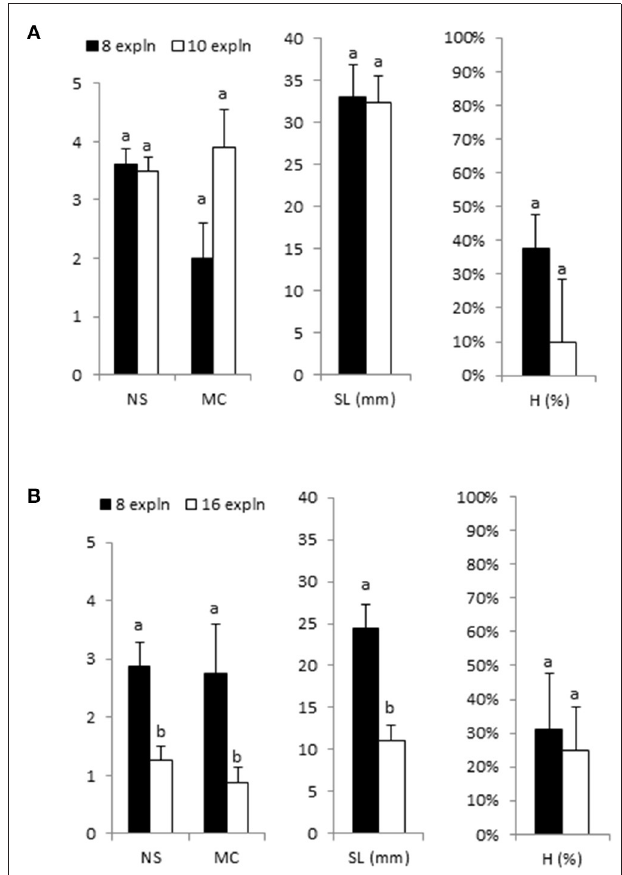
FIGURE 3 | Effect of initial explant number (8, 10, and 16 apical sections) on growth parameters of shoots of Beatriz (A) and Mati (B) genotypes cultured in RITA ® vessels in MS medium with half-strength nitrates and 2- µ M metatopoline. The explants were immersed for 1min every 8h. The data were recorded after 4 weeks of culture. The values represent the mean ± standard error. For each variable, different letters indicate significant differences at p < 0.05. NS, number of shoots per explant; MC, multiplication coefficient; SL, length of the longest shoot (mm); H, percentage of hyperhydric shoots.